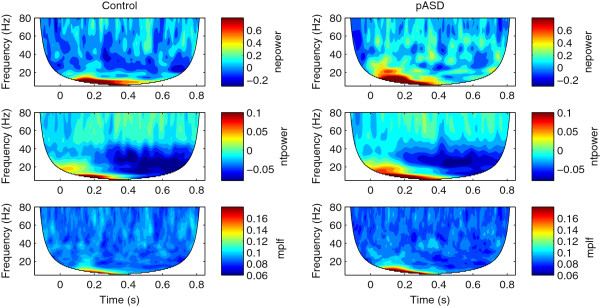
Left hemisphere time-frequency results. Time-frequency plots of the grand average across all ROIs for the control group (left column) and the pASD group (right column) for the left hemisphere. The rows show normalized evoked power (nepower), normalized total power (ntpower) and mean phase locking factor (mplf), respectively. The region in white is not analyzed because of incomplete filling of the wavelet near the edges.